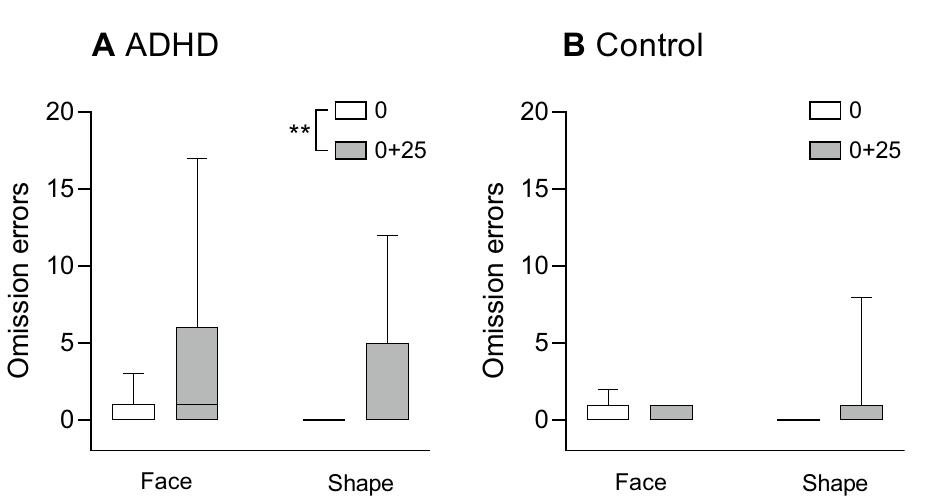
Figure 1. Boxplot (median, minimum–maximum) of the rates of omission errors on trials with target (angry) faces or target shapes for the ADHD group (A) and the control group (B). Differences between the rates of omission errors before (time 0) and after sleep deprivation (time 0 + 25) were examined across target type for each group using the Wilcoxon signed-rank test. **p <